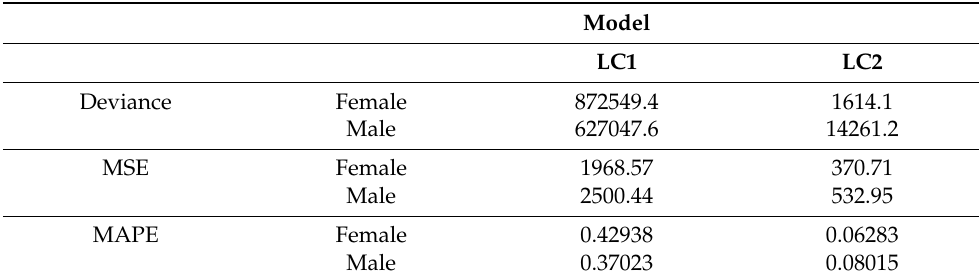
Table 1. Performance of LC1 and LC2